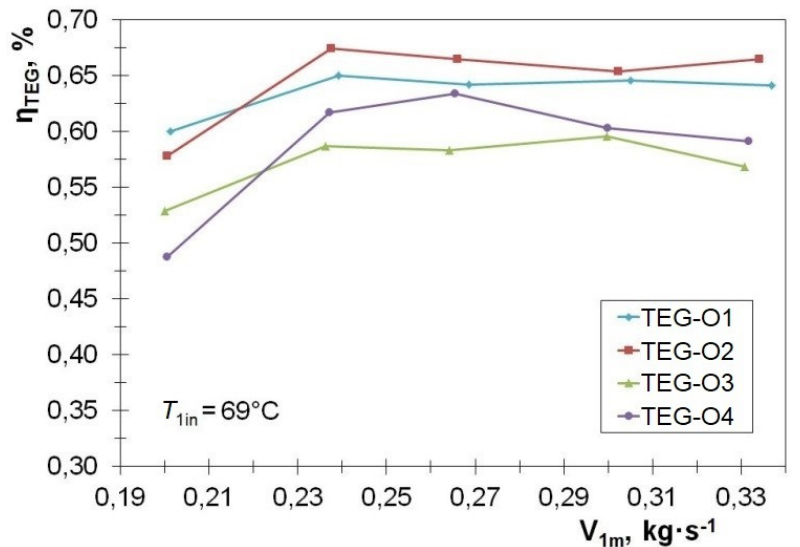
Figure 17. Efficiency characteristics of η TEG at different flow rates and cycles of the MTEG hot side fluid and temperature T 1 in = 69 ◦ C.